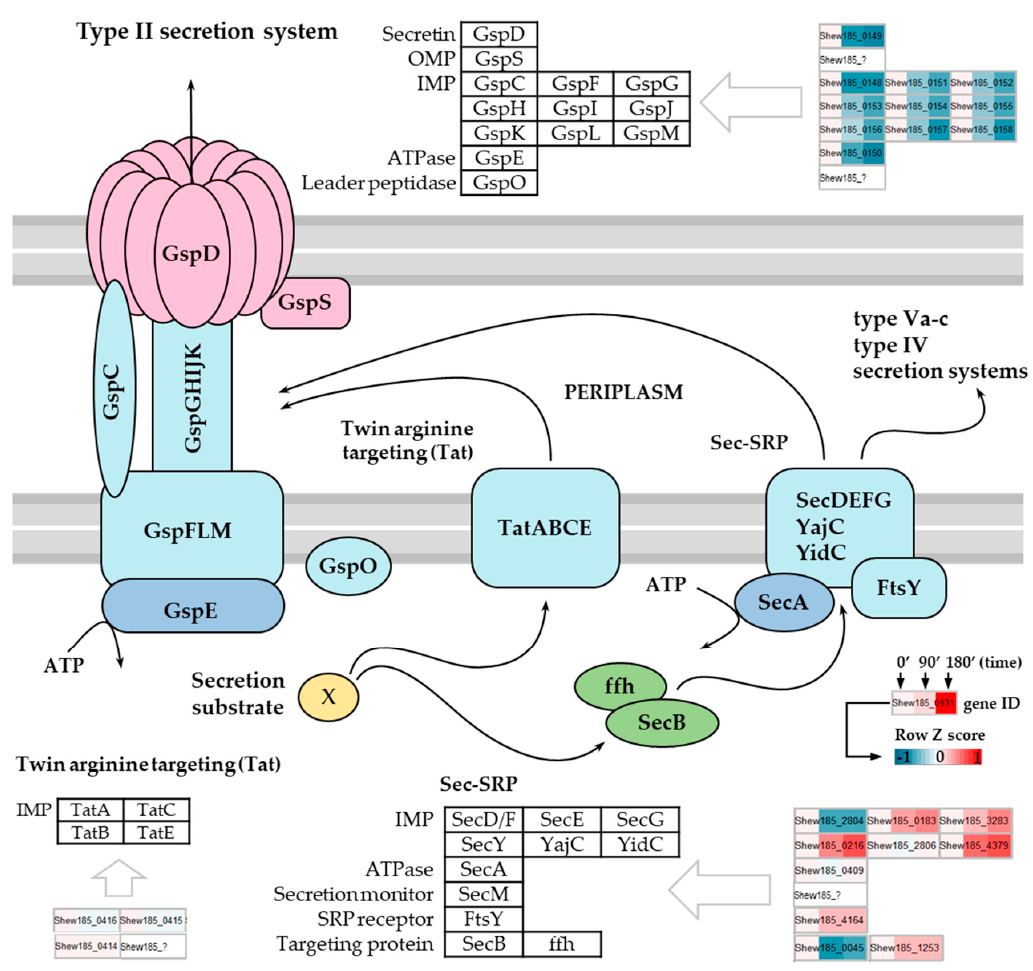
Figure 4. Expression changes affecting the S. baltica type II secretion system upon cold stress. Scheme